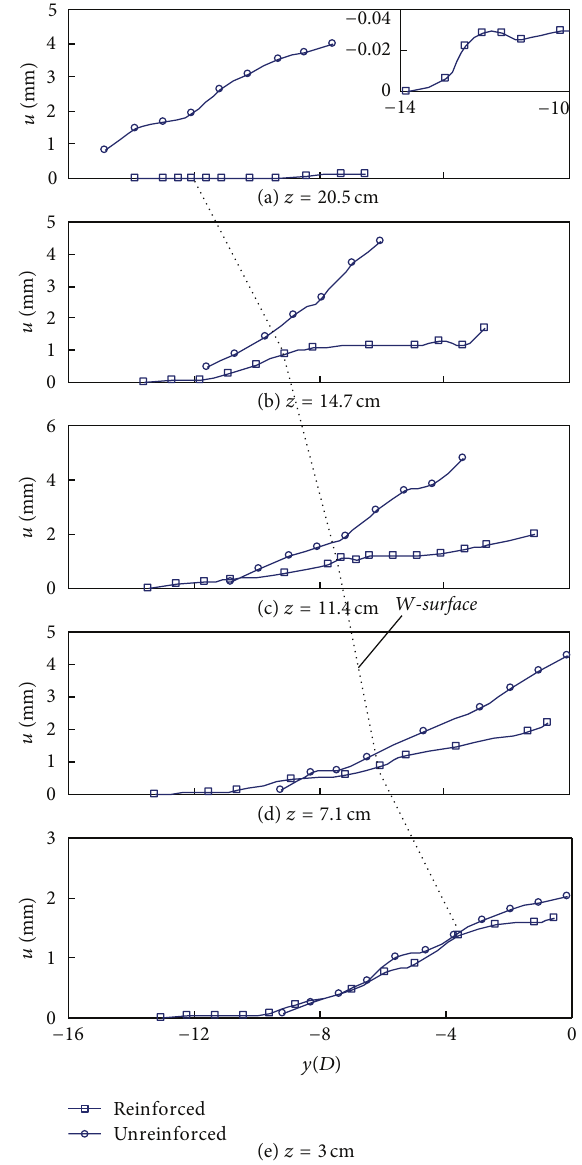
Figure 10: Horizontal displacement distributions on horizontal sections at 50g-level by test observation. u : horizontal displacement; D : pile